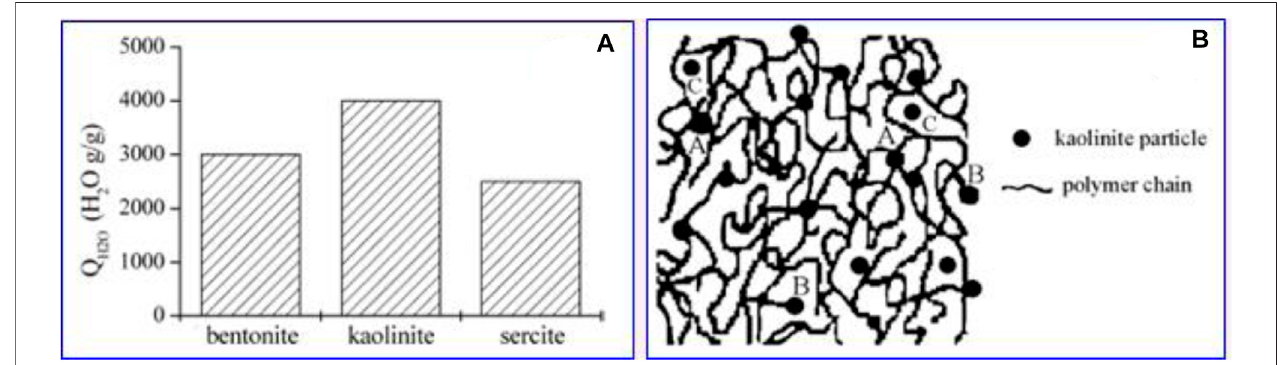
FIGURE6 |(A) Variation ofQ H2O ofstarch-graft-acrylamide/clay compositeswith bentonite, kaolinite, and sercite using clay(10 wt%) and potatostarch (20 wt%). (B) Model for the cross-linkage structure. Reprinted with permission from Wu et al. (2003a). Copyright (2003) Elsevier